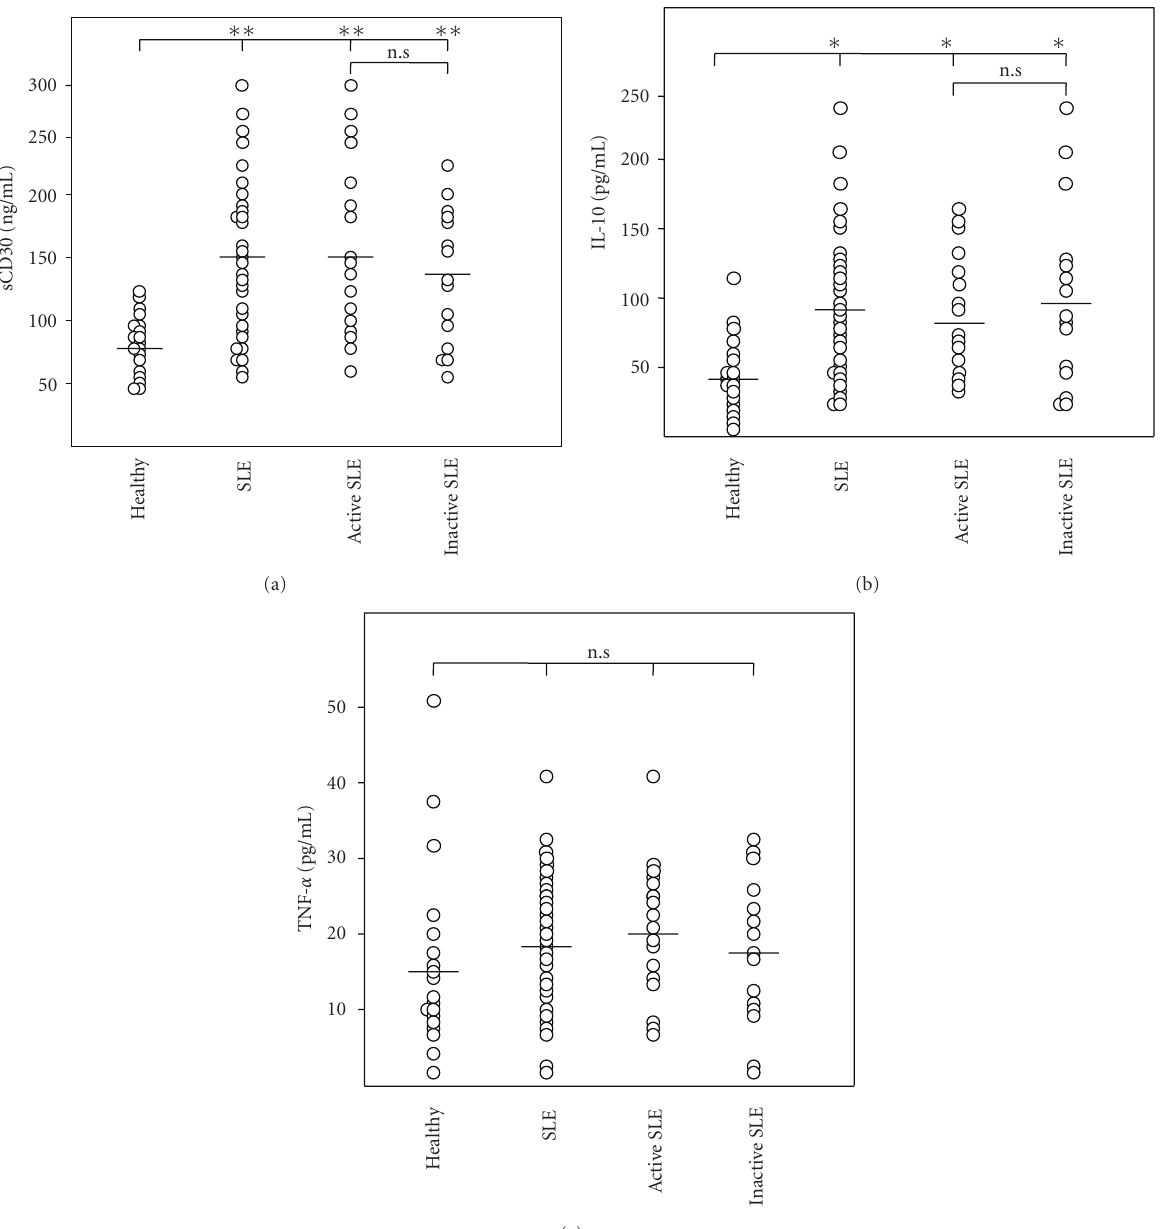
Figure 3: Serum levels of sCD30 (a), IL-10 (b) and TNF- α (c) in the SLE group, in the healthy controls, in the subgroups with active and inactive SLE. ∗ Statistically significant di ff erences between the healthy controls and the marked SLE group & subgroups ( P < . 01).